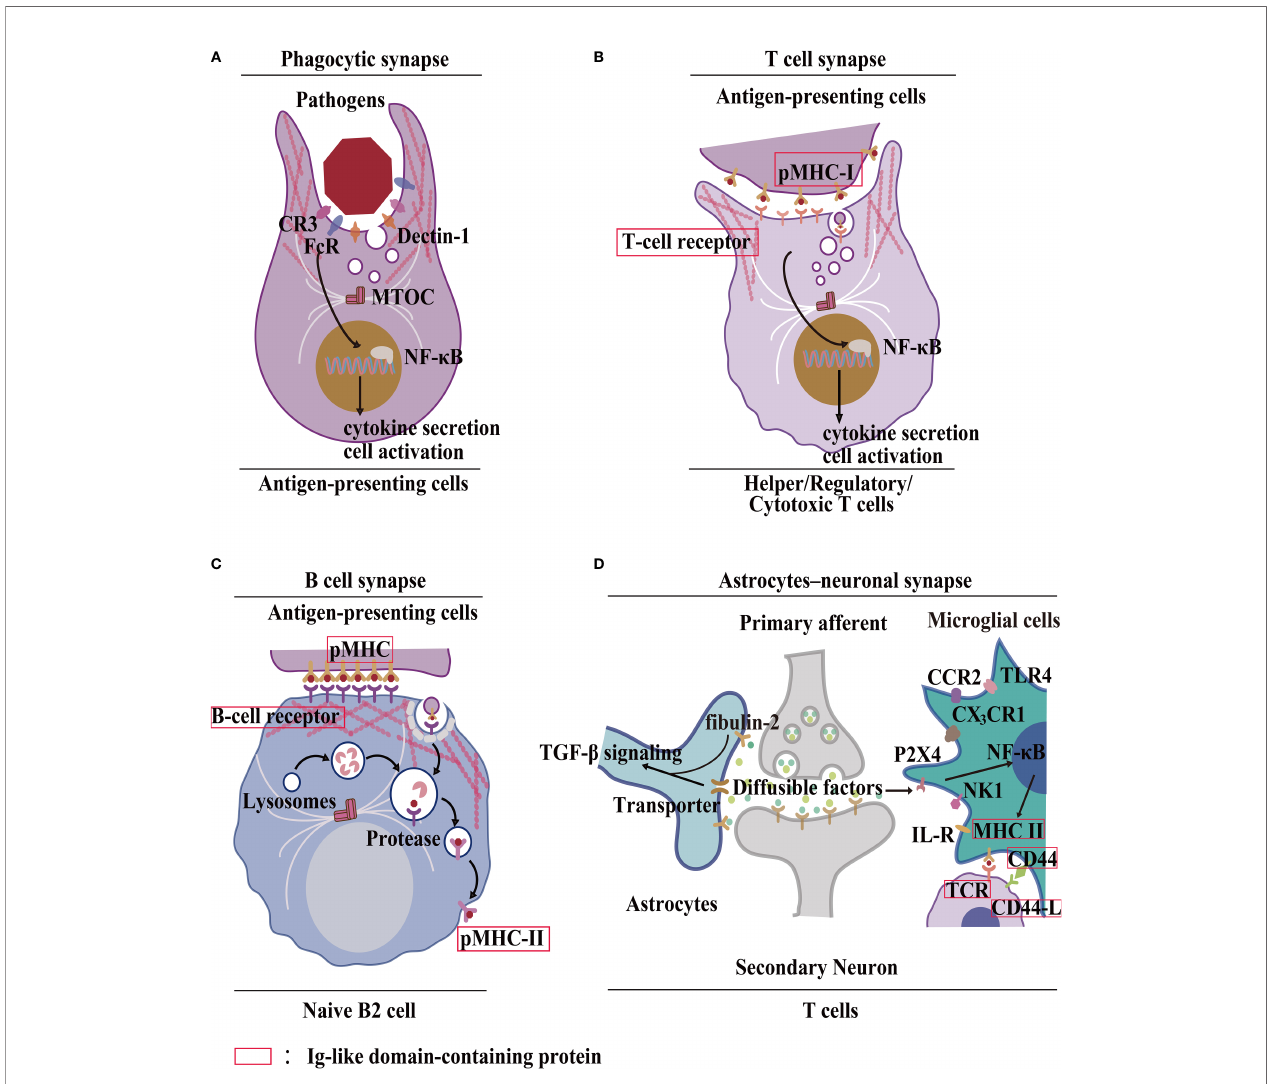
FIGURE 2 | Formation of the IS by HC – IGLDCP interaction. (A) A phagocytic synapse formed by APCs. Phagocytes possess speci fi c molecules on the synaptic surface that trigger phagocytosis. For example, recognition of Fcy receptor (FcR) sites, CR3 envelope site, Dectin-1 receptor trigger site (41). MTOC: Center for Microtubule Organization. (B) T-cell immunological synapse. A speci fi c cellular contact between T cells and APCs. Major histocompatibility complex (pMHC-I) molecules on the surface of APCs bind to the T-cell receptor (TCR) and deliver the antigen, leading to the polarization of APCs by T cells and the coordinated recombination of various components of T cells, including signaling molecules and adhesion molecules, actin and microtubule cytoskeleton (41). (C) B-cell immunological synapse. A speci fi c cellular contact between B cells and APCs. The pMHC-I molecules are phagocytosed in a clathrin-dependent manner. The antigens are transported to lysosomal vesicles for digestion, and the resulting peptides are loaded onto MHC-II molecules and transported back to the cell surface for presentation to T cells (42). (D) Neuronal Synapse. It consists of neurons, astrocytes, microglia, and T cells. Astrocyte-derived extracellular vesicles promote synapse formation through fi brin 2-mediated TGF- b signaling. Microglia MHC-II protein, CD40, and other stimulating molecules recruit T cells to deliver antigens. Different receptors bind to different ligands (43, 44). HC, hemichannel; IGLDCP, Ig-like domain-containing protein; Cx, connexin; Panx, pannexin; APC, antigen- presenting